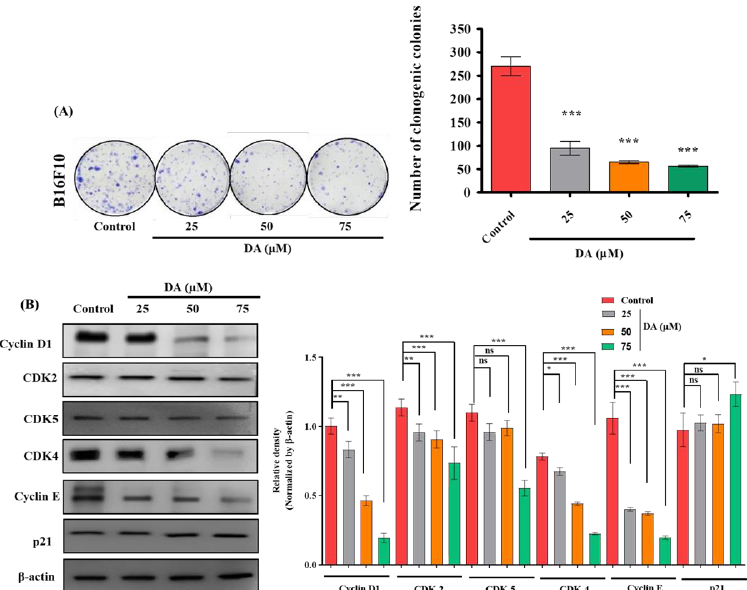
Figure 2. ( A ) Clonogenic assay and quantification of B16F10 cells cultured in the presence and absence of DA over 7 days, followed by crystal violet staining. ( B ) DA was treated to B16F10 cells for 24 h and cell cycle protein levels were detected, such as cyclin D1, CDK2, 5, 4, cyclin E, and p21. Densitometry analysis of the respective proteins was evaluated by Image J software, and results were normalized with β -actin. The data are represented as the means ± standard deviation (SD) of three independent experiments; ns — non-significant; * p < 0.05, ** p < 0.01, *** p < 0.001 vs. control, calculated through ANOVA prism.